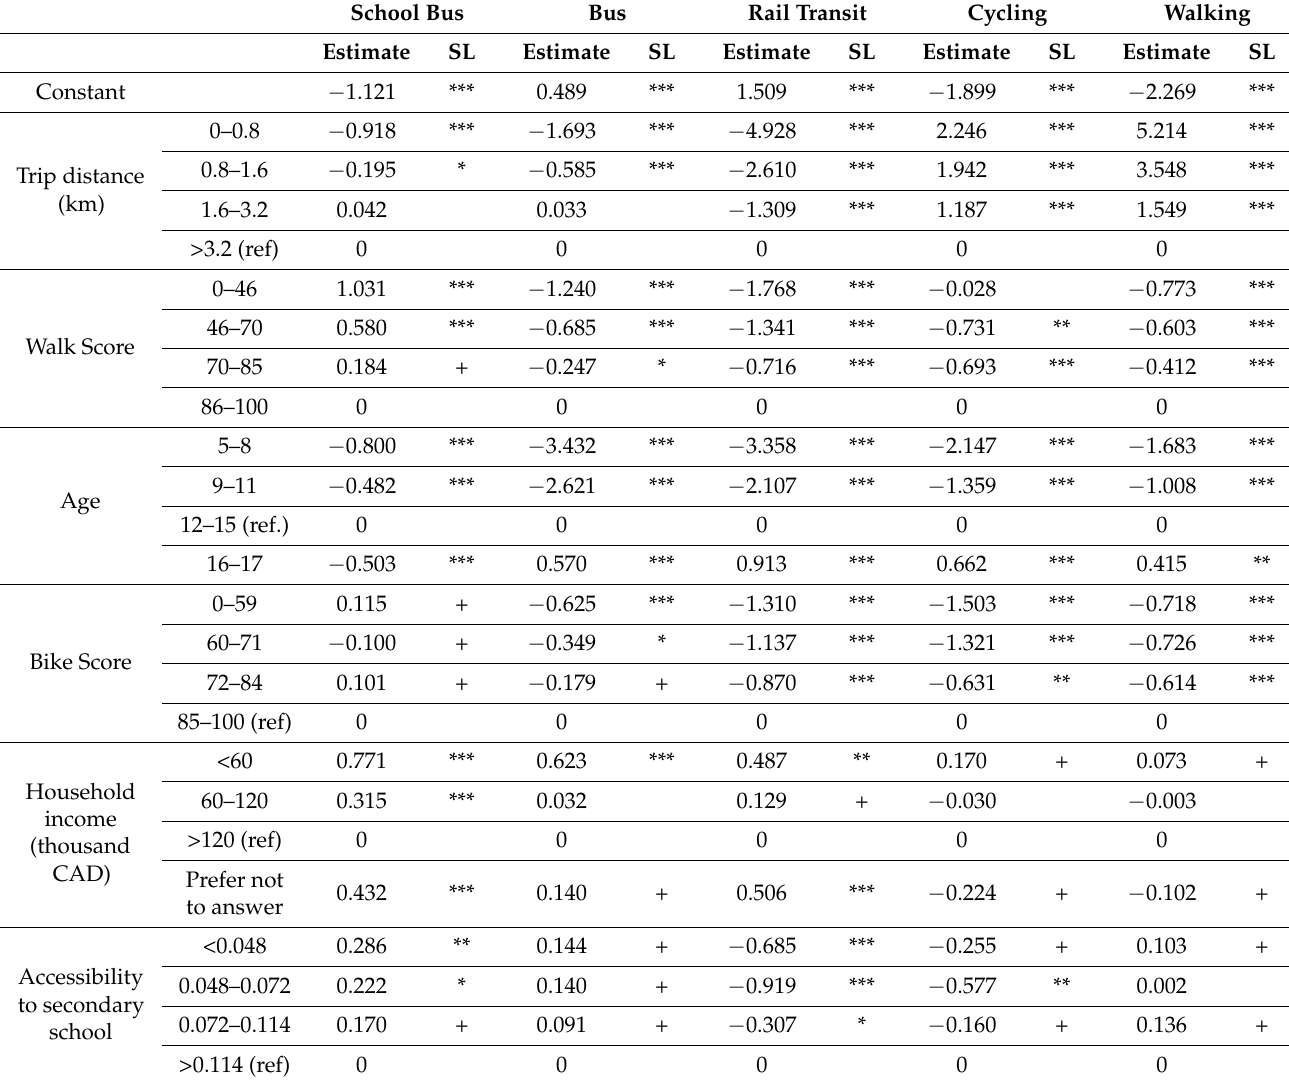
Table 5. Results of multiple logistic regression (variables are organized by relative influence from most to